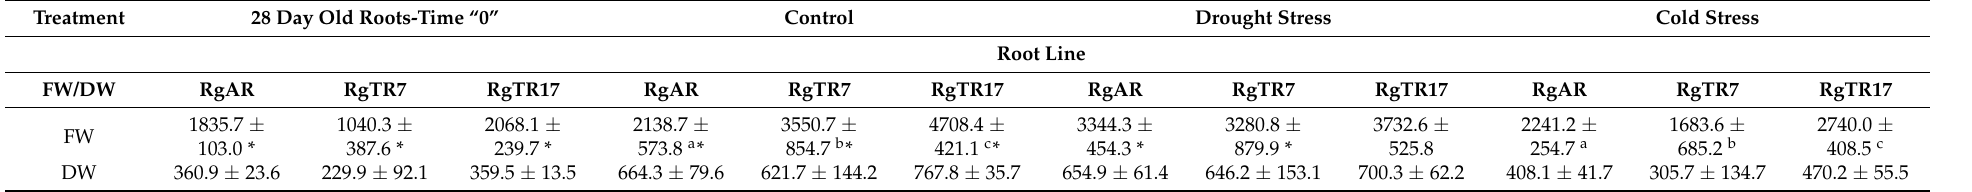
Table 1. Biomass [mg] of R. graeca roots cultivated under various